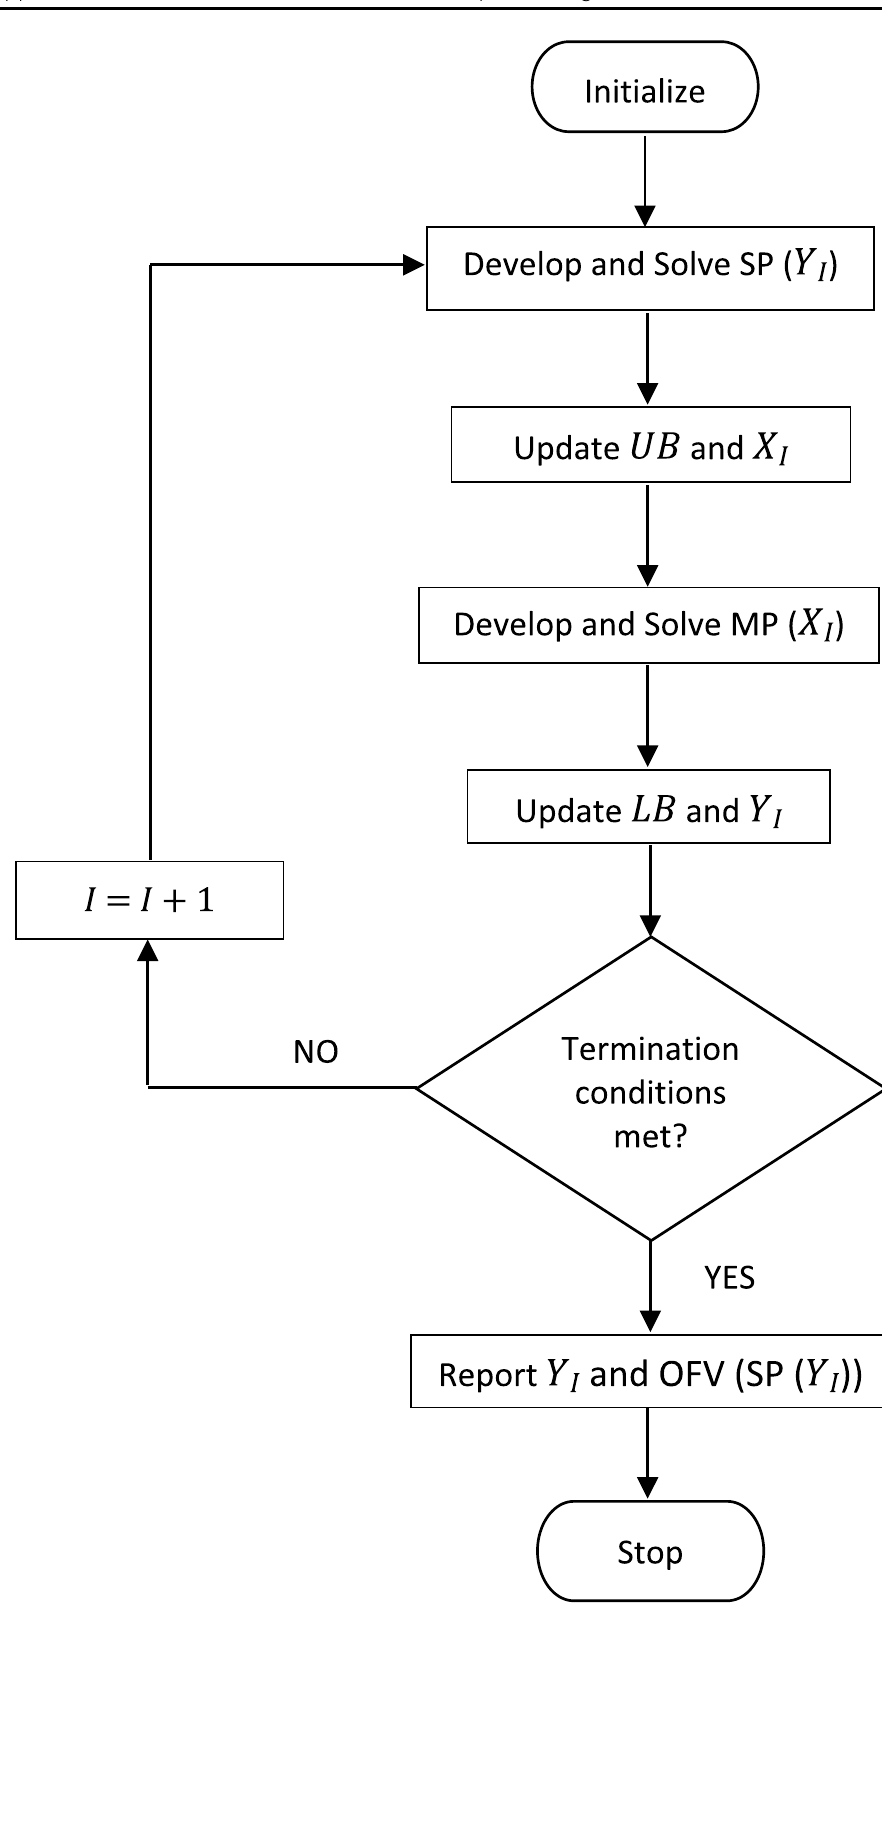
Fig. 2 Flowchart of the decom- position